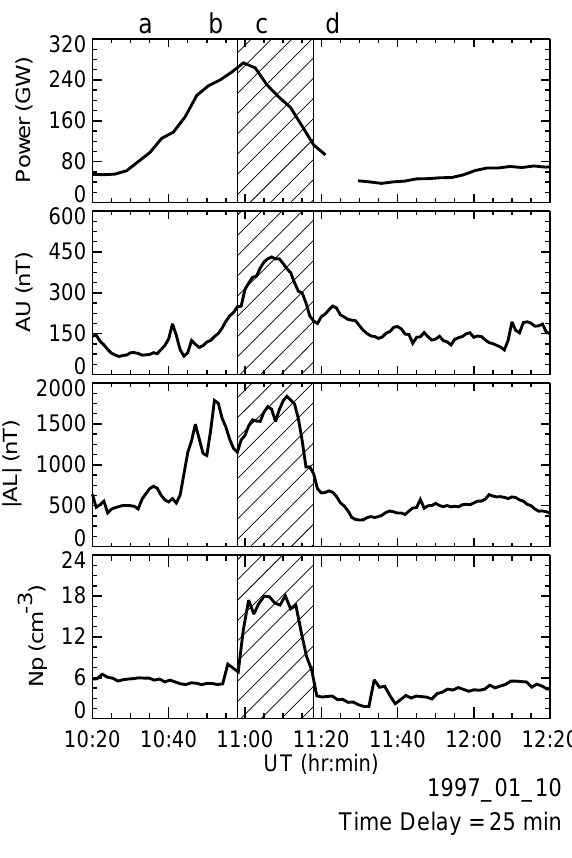
Fig. 4. The format is the same as Fig. 2 except for the 10 January 1997 event and the shifted time of 25min in the solar wind density. The labels a–d on the top of the power panel are referred to the auroral images shown in Fig.